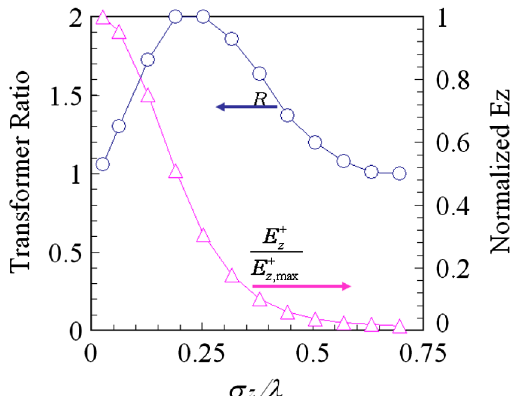
FIG. 2. Transformer ratio for a single bunch. R and peak accelerating field, E þ z , as a function of the normalized bunch length ( (cid:2) z =(cid:1) ). The plot is from Ref. [5]. (Single mode operation was assumed in the